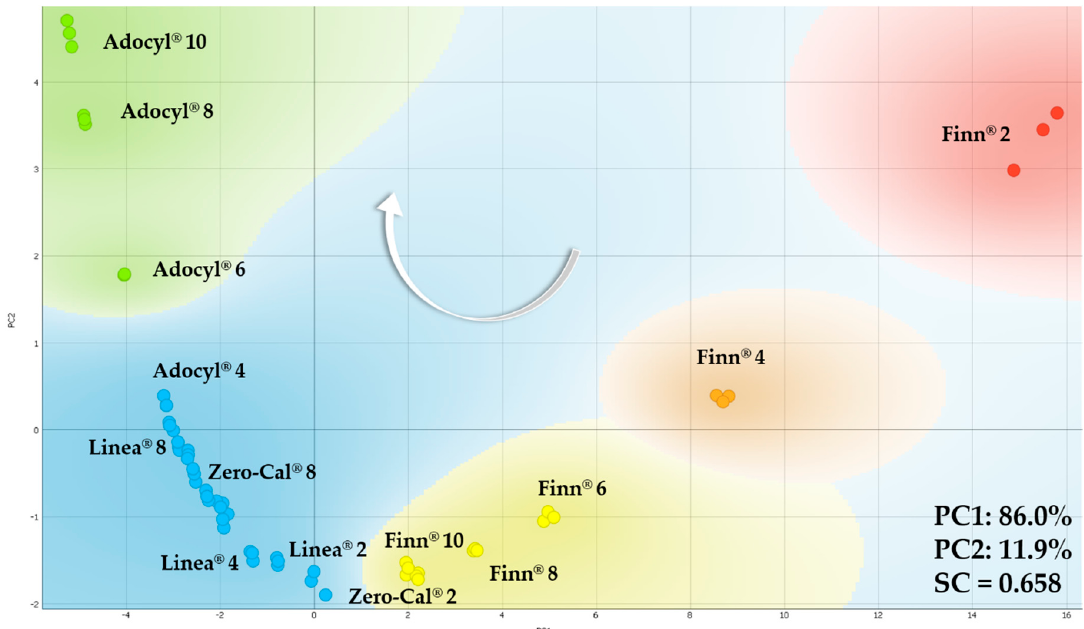
Figure 15. PCA plot for the sucralose-based sweeteners in distinct concentrations in deionized water (from 2 to 10 µL/mL) obtained using the impedimetric microfluidic e-tongue at 5 mL/h flow rate. The number in front of the sweetener brand represents their respective concentration. The white arrow indicates the direction of increasing concentration for all the brands tested.